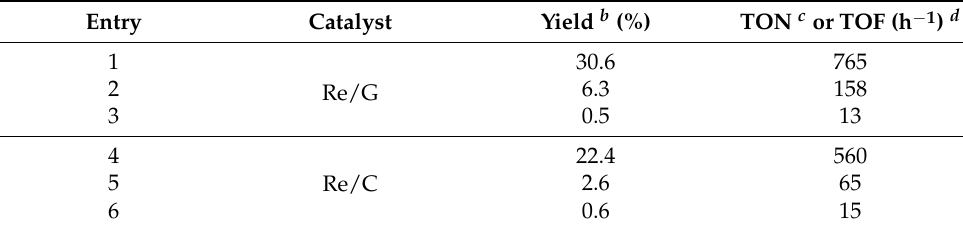
Table 4. Recycling studies a of Re/C or Re/G as heterogeneous catalysts for the MW-assisted oxidation of 1-phenylethanol to